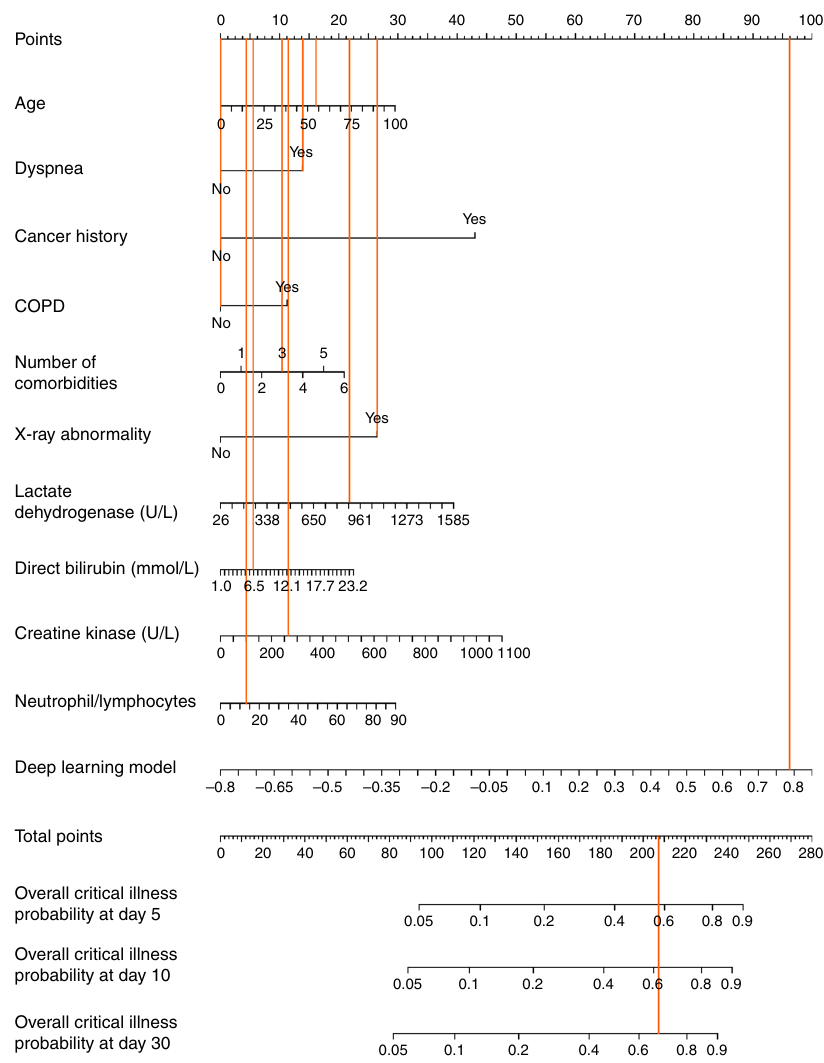
Fig. 3 Nomogram of the Deep Learning Survival Cox model to triage COVID-19 patients. The patient ’ s total nomogram point is 209, overall critical illness probabilities are 0.58, 0.62, and 0.69 within 5, 10, and 30 days, respectively. The patient is triaged as